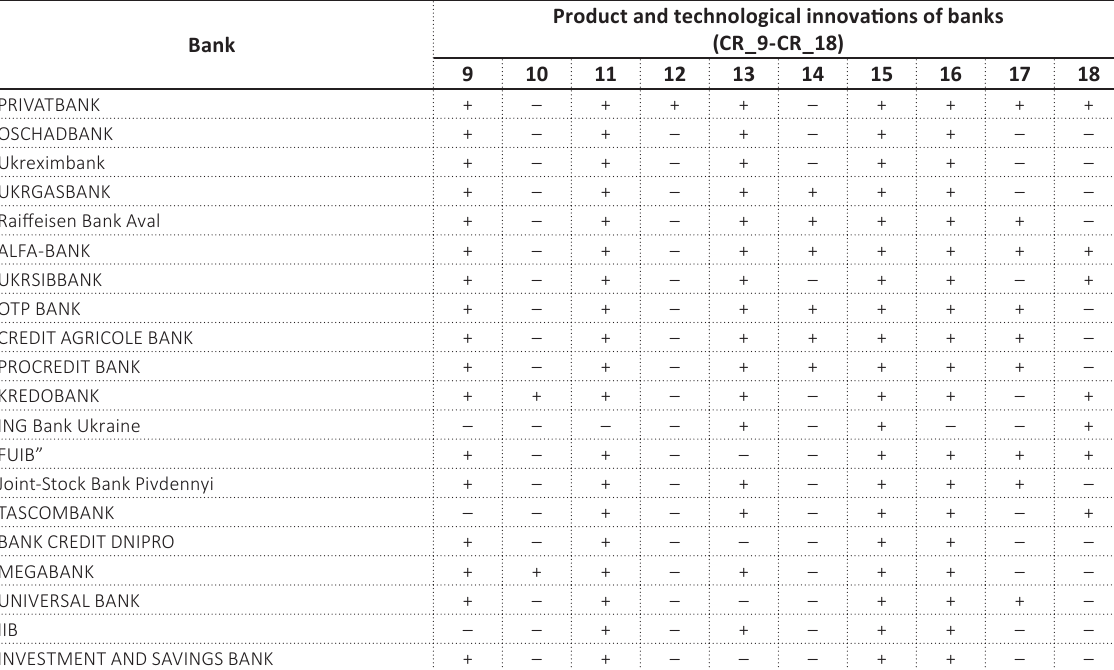
Table 9. Comparison results of Ukrainian banks on the intensity of innovation promotion in the field of enterprise servicing Source: Summarized by the authors based on information provided on the banks’ official